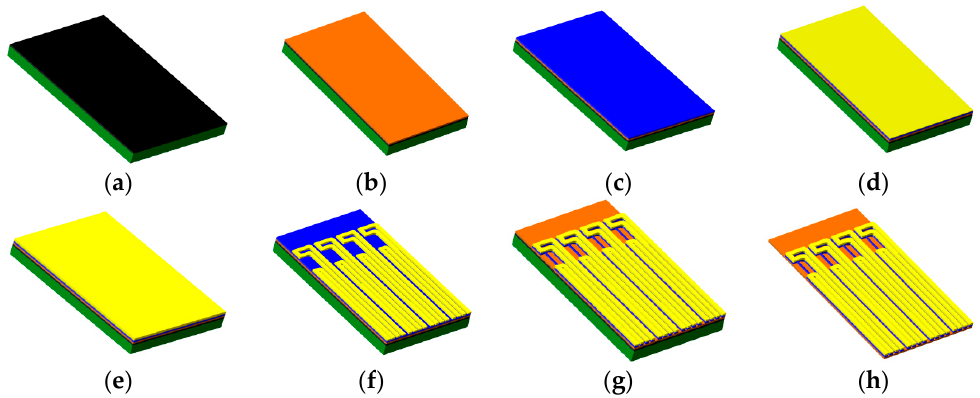
Figure 2. Fabrication processes of the flexible hot-film sensor array.